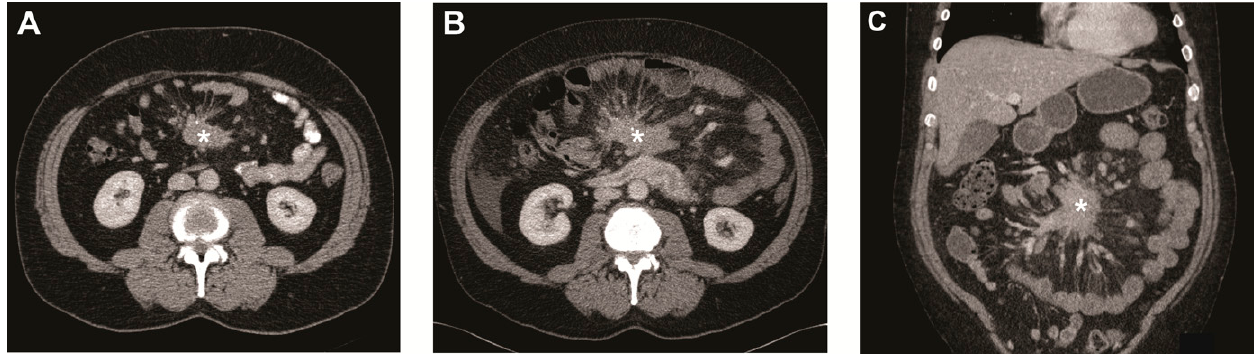
Figure 1. Metastatic mesenteric mass and surrounding fibrosis over time. ( A ) Transverse image of CT scan at baseline showing mesenteric mass (asterisk) with radiating strands of fibrotic tissue. Transverse ( B ) and coronal image ( C ) of CT scan after 5 years showing the mesenteric mass (asterisk) growth of >20% on the short axis.